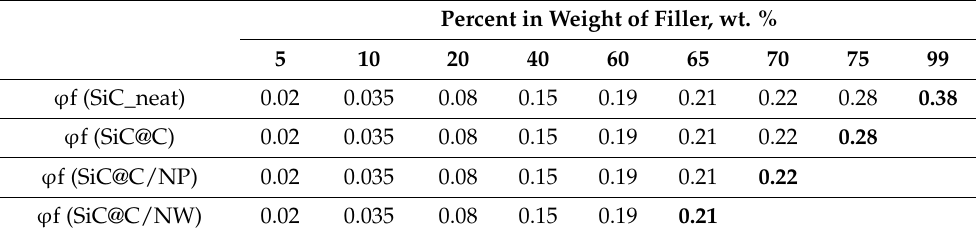
Table 2. Values of the weight concentration and volume filler’s fraction. Percent in Weight of Filler, wt. %